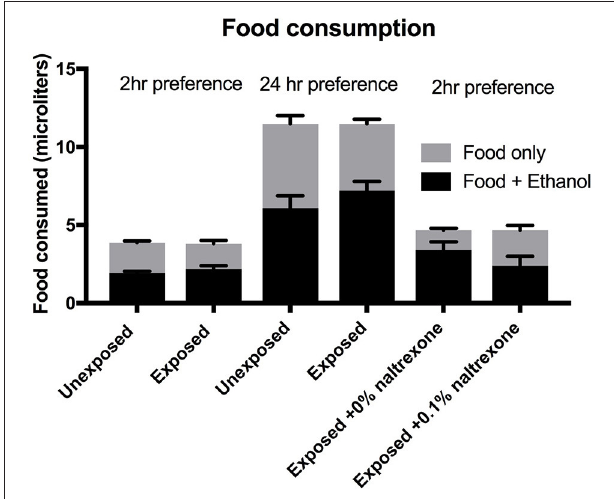
FIGURE 4 | Food consumption. Flies were either exposed or unexposed to 15% ethanol for 48 h or exposed to ethanol for 48 h followed by treatment with 0 or 0.1% naltrexone. The consumption was measured over a period of 2 or 24 h as indicated. Each column represents triplicate assays containing 6 flies each, n = 3. Error bars are SEM. One-way ANOVA with Kruskall-Wallis multiple comparison analysis showed no significant difference ( p > 0.9) between any of the groups where consumption was measured for the same length of time. The Preference indices for the data shown for this figure for the 6 columns left to right are 0.0; 0.16; 0.02; 0.26; 0.48; 0.03.